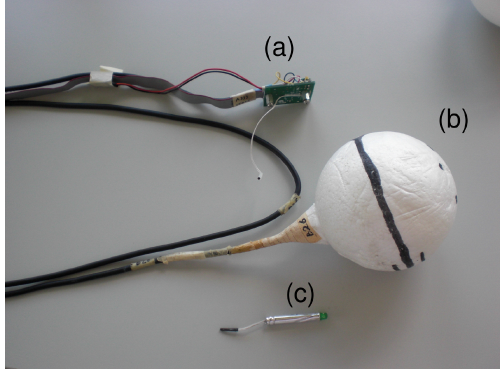
Figure 1. Photo of the light sensor: (a) data transmitter, (b) sphere, (c) green